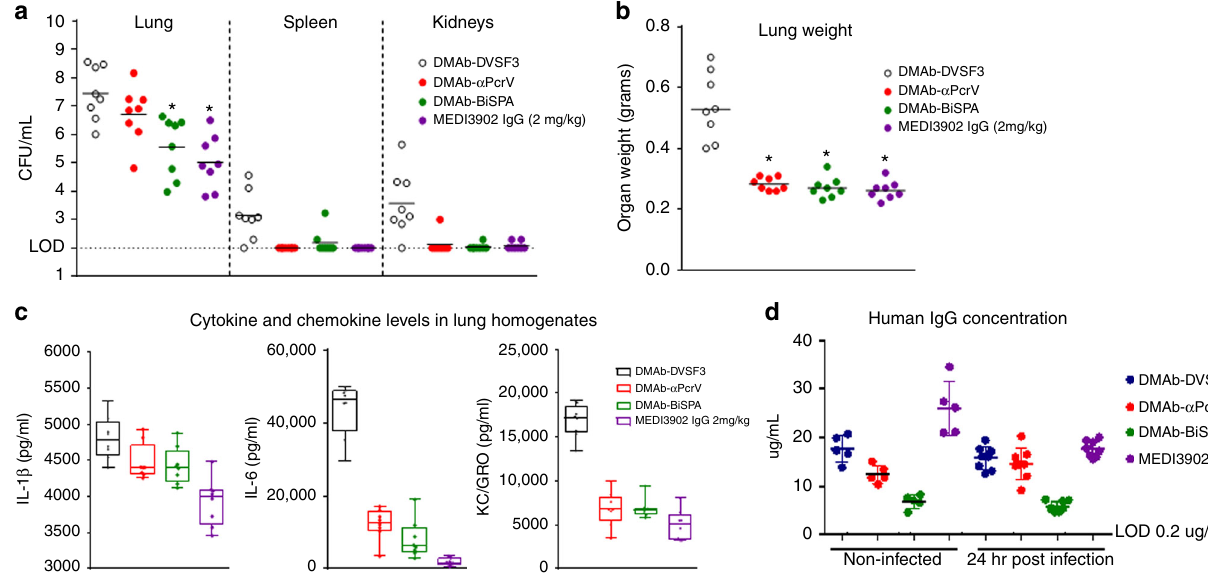
Fig. 5 Organ protective effect of DMAb- α PcrV and DMAb-BiSPA. a Organ burden of P. aeruginosa bacteria (CFU per ml) was quanti fi ed from lung, spleen, and kidneys following lethal pneumonia challenge in animals treated with DMAb-DVSF3, DMAb- α PcrV, DMAb-MEDI3902, or MEDI3902 IgG. b Lung weight in infected animals following DMAb-treatment. c Levels of pro-in fl ammatory cytokines and chemokines in lung homogenates of DMAb-treated animals following lethal challenge. a – c n = 8 mice/group. The line represents the mean value. Box and whisker plots display all points and bars indicate minimum to maximum values. d Serum IgG levels of DMAb and MEDI3902 IgG in uninfected animals compared with infected animals at 24 h